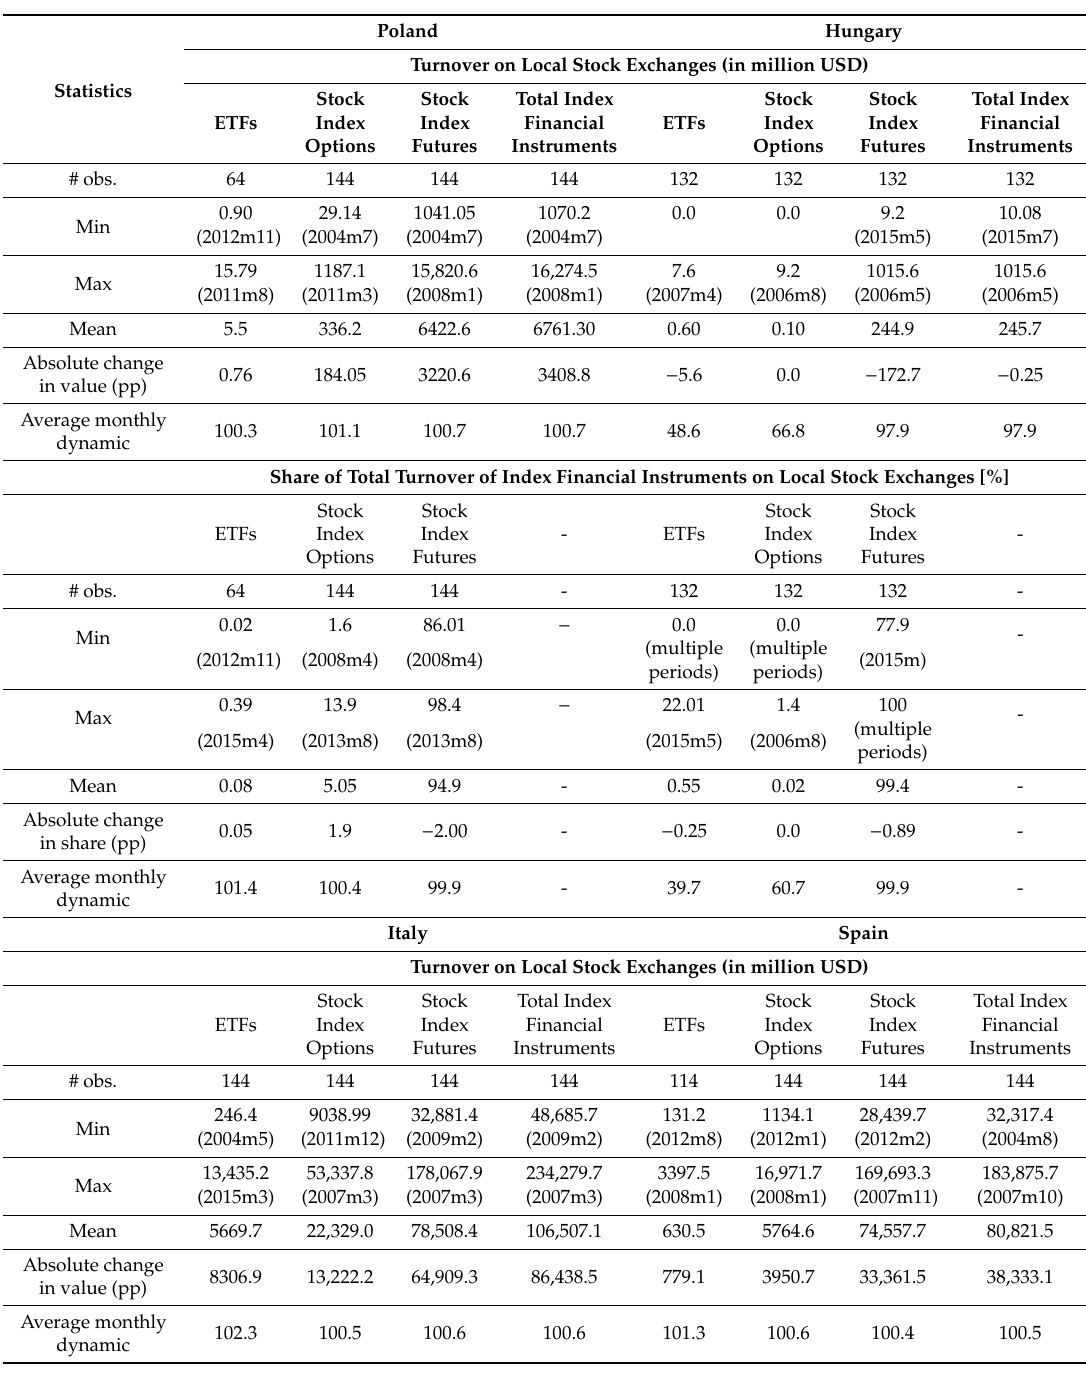
Table 2. Summary statistics for exchange traded funds, stock index options, stock index futures and total index financial instruments. Monthly data for 2004–2015. For ETFs, the periods of analysis are: Poland, 2010m9–2015m12; Hungary, 2007m1–2015m12; Italy, 2004m1–2015m12; Spain, 2006m7–2015m12; Germany, 2004m1–2015m12; and France, 2004m1–2015m12. The number of ETFs varies across time periods and